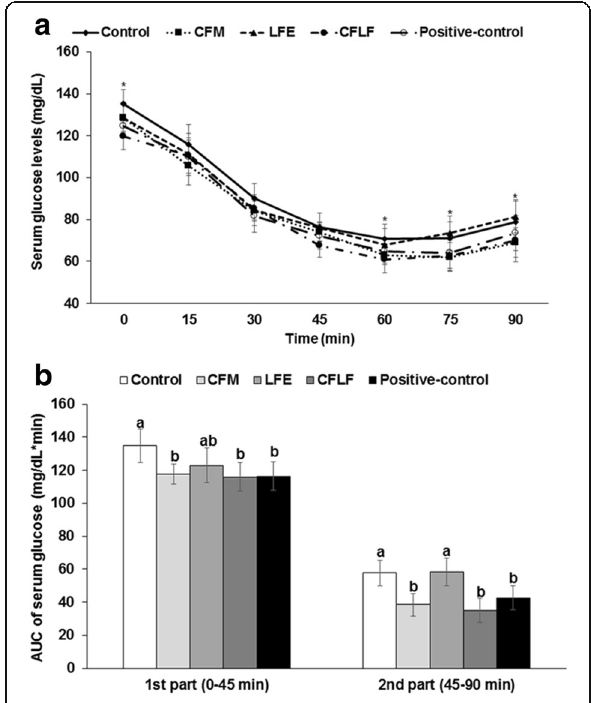
Fig. 3 Changes in serum glucose concentrations during the insulin tolerance test (ITT). Control, OVX rats fed a high-fat diet (HFD) with 1% dextrin; CFM, OVX rats fed an HFD with 1% lyophilized cauliflower mushroom; LFE, OVX rats fed an HFD with 0.1% L . fermentum plus 1% dextrin; CFLF, OVX rats fed an HFD with 1% CFM plus 0.1% L . fermentum ; positive-control, OVX rats fed an HFD with 1% dextrin plus 30 μ g/kg body weight 17 β -estradiol. ITT was conducted with intraperitoneal injection of 0.75 IU insulin/kg body weight and measured serum glucose concentra- tions in blood collected from the tail every 15 min for 90 min. Changes of serum glucose concentrations were shown during ITT ( a ). The average of the area under the curve (AUC) of glucose during the first part (0 – 45 min) and second part (45 – 90 min) of ITT ( b ) was given. Each dot and bar repre- sents the mean ± SD ( n = 12). Asterisk indicates significantly different among the treatments of OVX rats at p < 0.05. Different letters represent a significant difference in Tukey test at p <